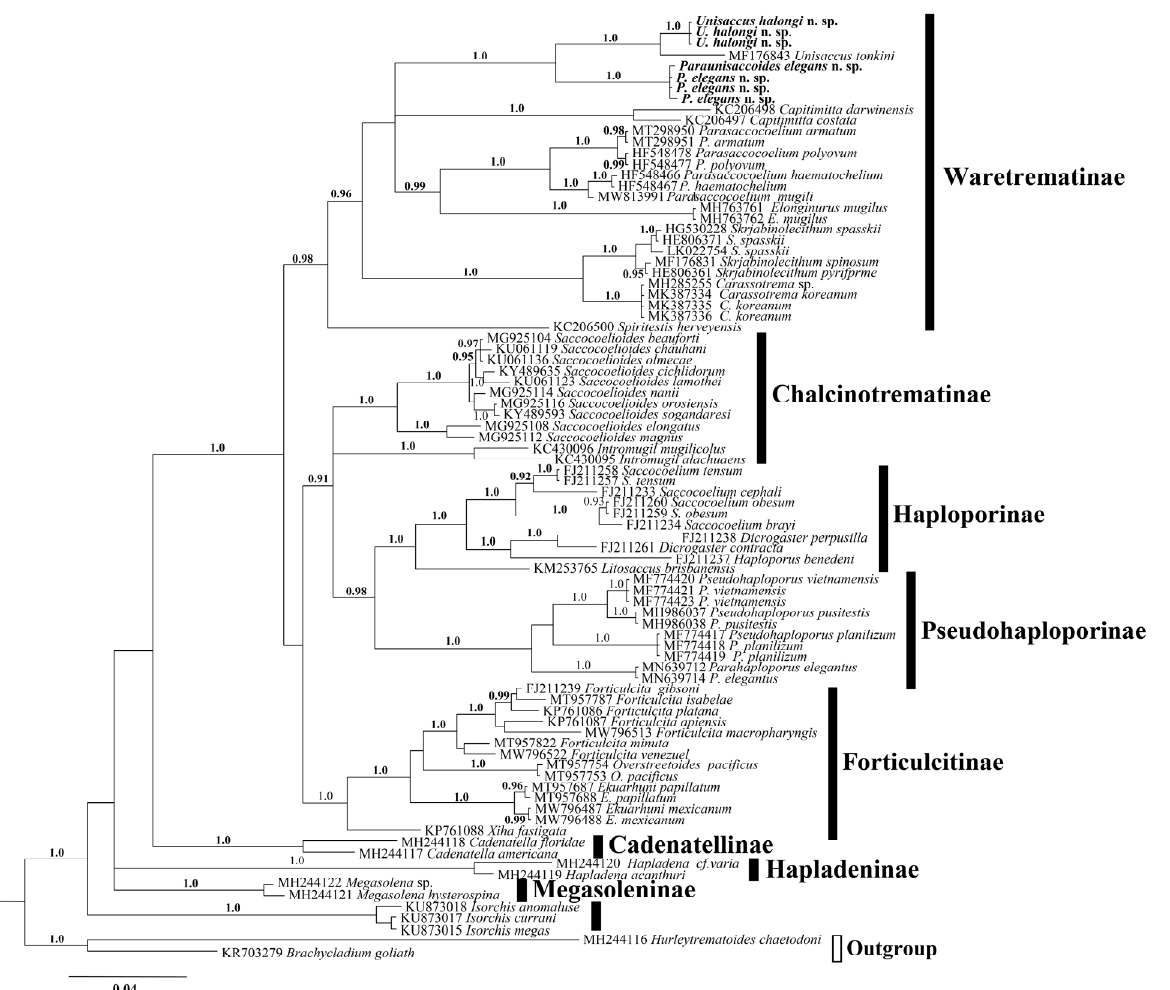
Figure 2. Phylogenetic relationships of the family Haploporidae obtained with Bayesian algorithm based on partial 28S rRNA gene (alignment length 1050 bp). Nodal numbers—posterior probabilities that indicate statistical support of phylogenetic relationships, only significant values (0.9–1.0) are showed.